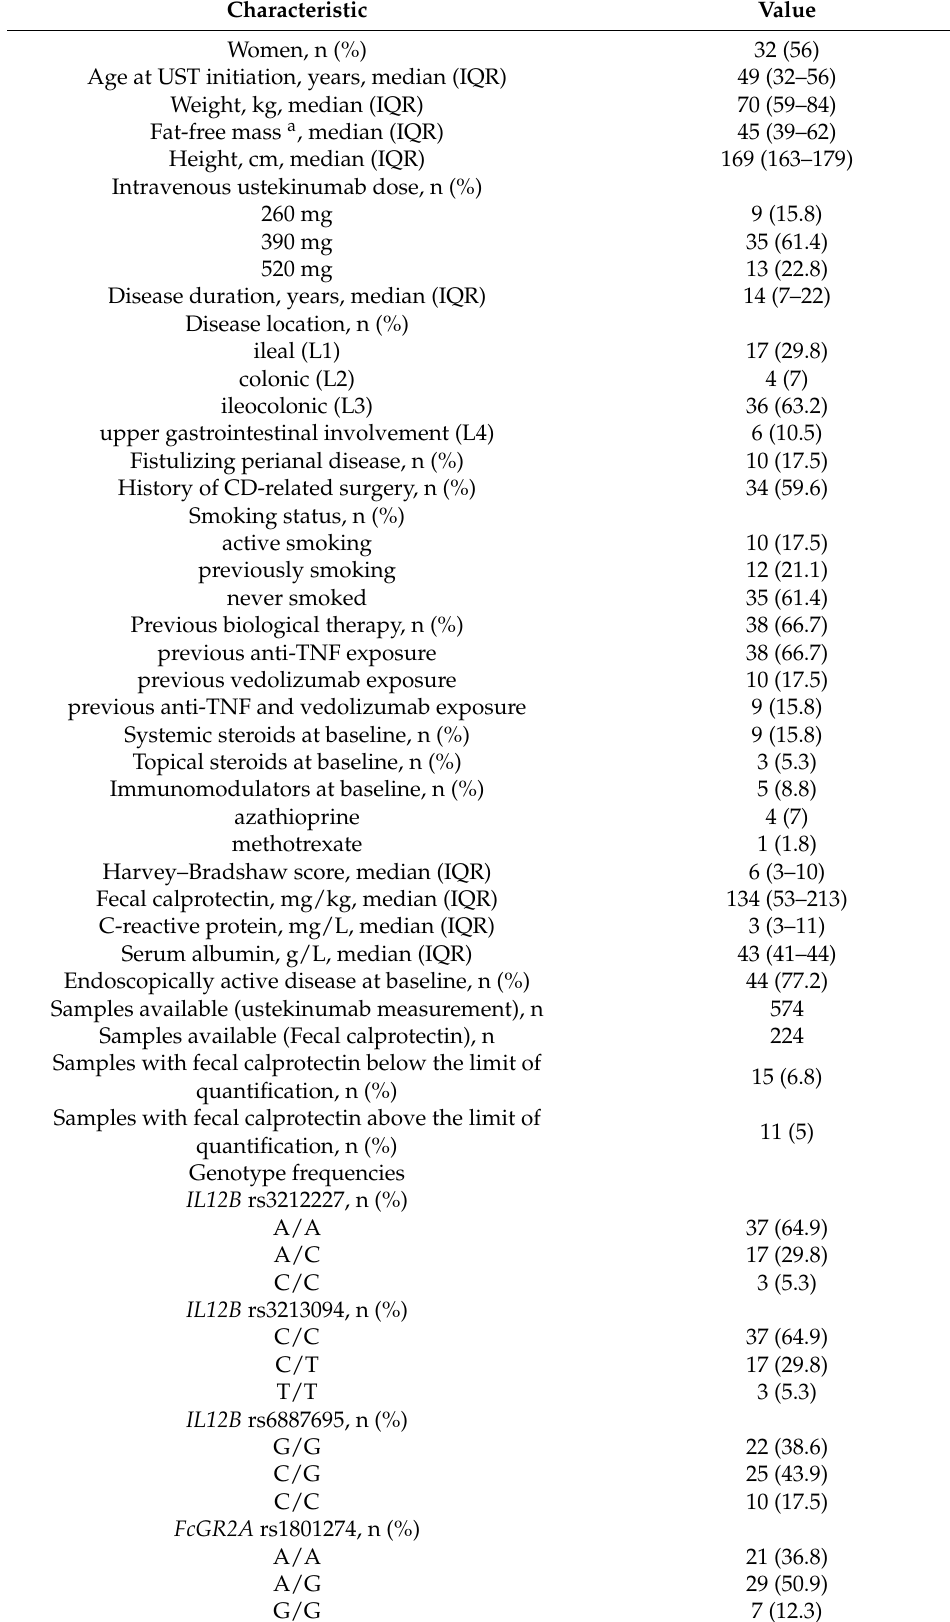
Table 1. Patients’ characteristics at baseline (n =